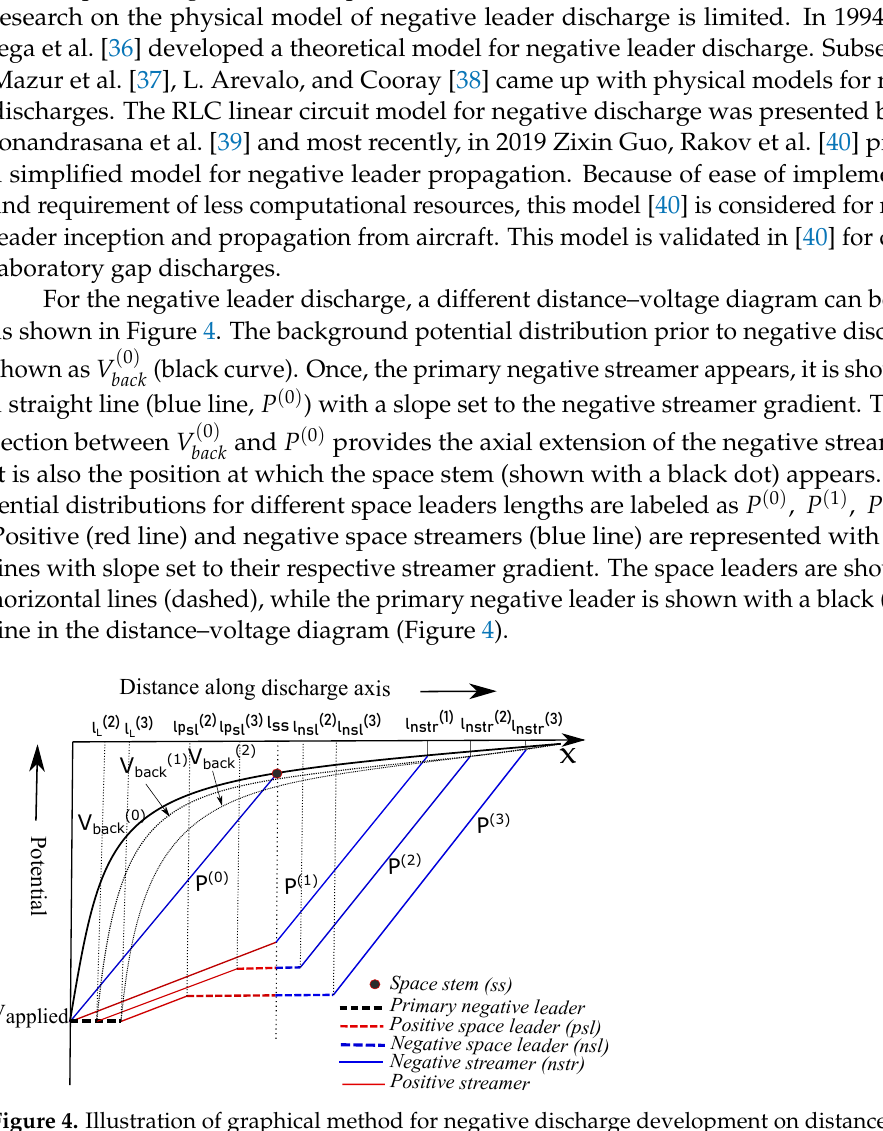
Figure 4. Illustration of graphical method for negative discharge development on distance–voltage diagram as described in